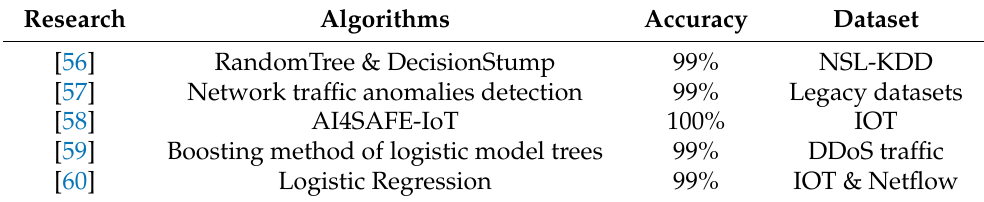
Table 13. The Comparison with other research results in the